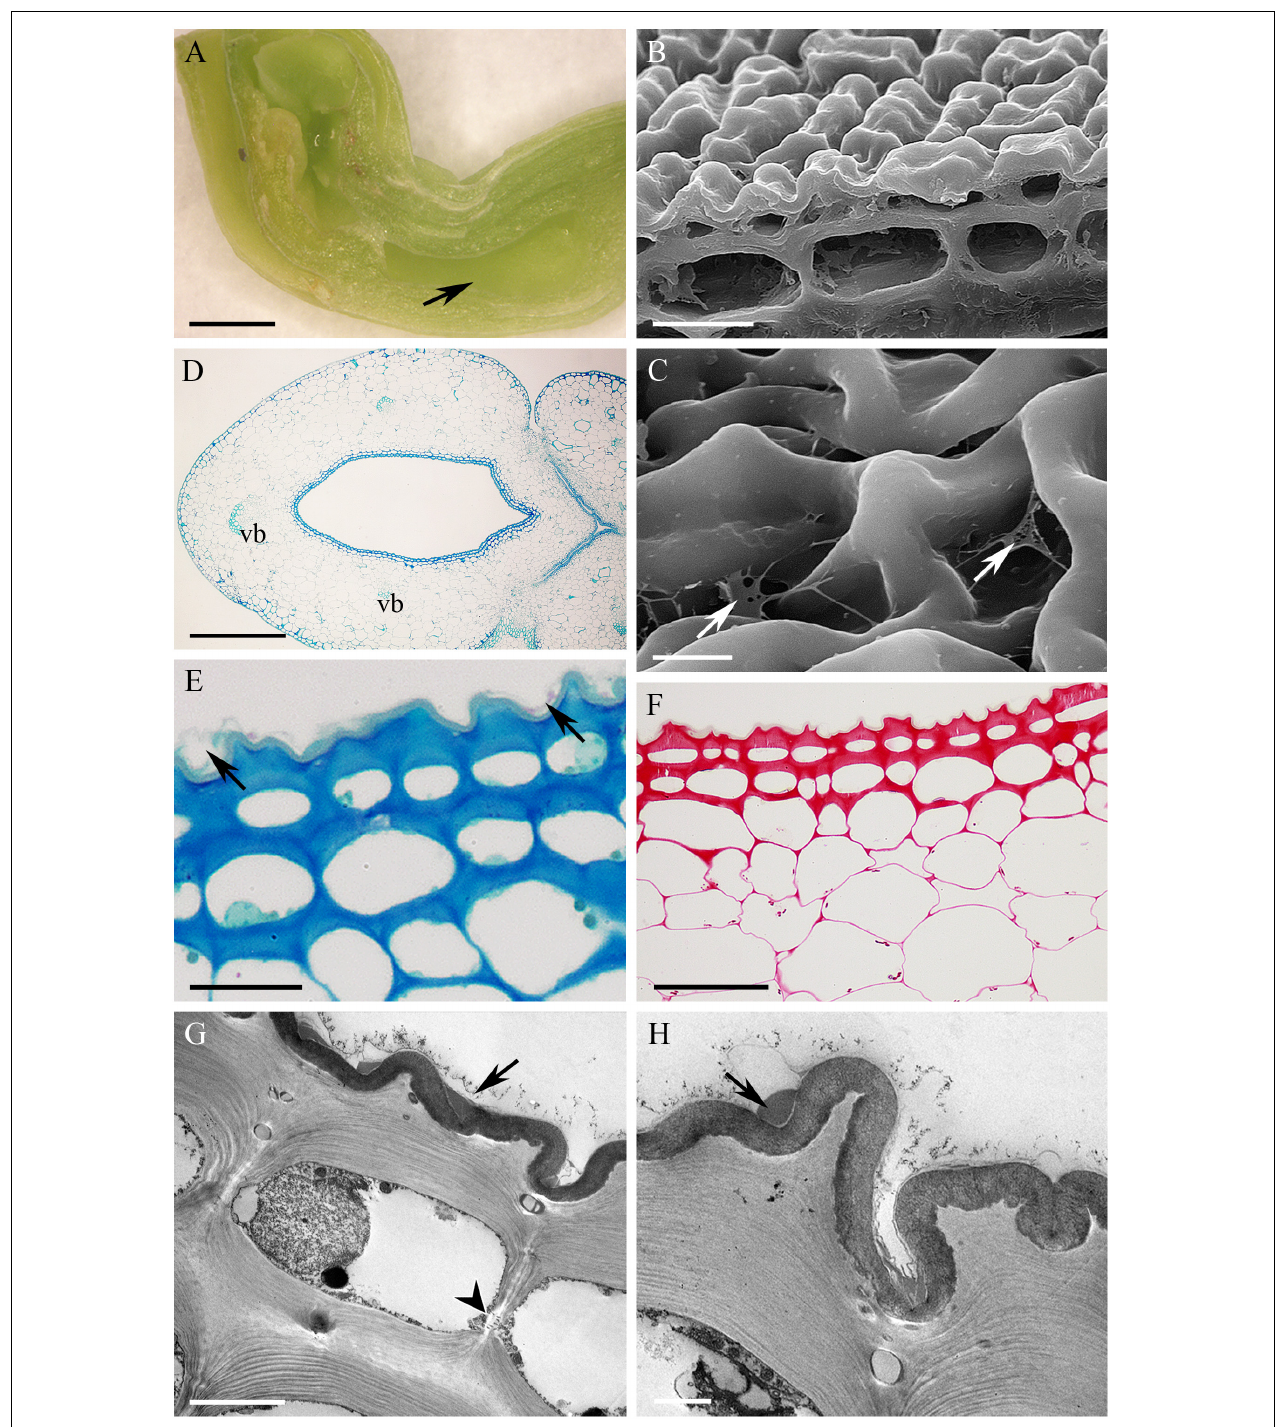
FIGURE 4 | Epidendrum rigidum . (A) Longitudinal section of flower showing cuniculus (arrow). (B) Detail of small, thick-walled epidermal cells with convoluted cuticle, and larger subepidermal parenchyma cells. (C) Detail of cuticle with nectar residues (arrows). (D) Transverse section of ovary showing cuniculus enclosed by epidermis and parenchyma containing vascular bundles (MB/AII). (E) Detail of collenchymatous epidermis and subepidermal parenchyma. Note thin cuticle with secretory residues (arrows). (F) The PAS reaction stains cell walls and occasional starch grains in ground parenchyma. (G) Epidermal cell lining cuniculus, with large nucleus and parietal cytoplasm containing osmiophilic globules. Secreted surface material occurs on the cuticle (arrow). Plasmodesmata in anticlinal cell wall marked with arrowhead. (H) Detail of outer wall of epidermal cell lining cuniculus, showing cuticle with nectar residues (arrow) and cavity in middle lamella. Scale bars: A = 1mm; B,C,E = 20 µ m; D,G = 5 µ m; D = 500 µ m; F = 50 µ m; H = 2 µ m.